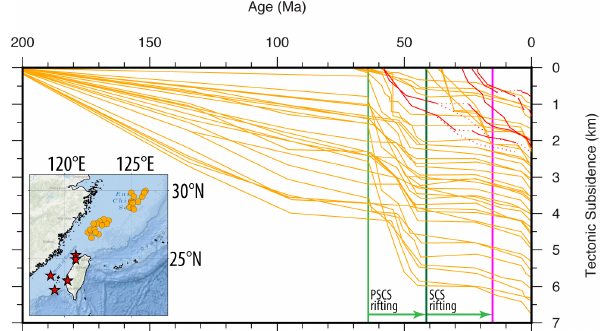
Fig. 15. Tectonic subsidence records from basins adjacent to Tai- wan and east China indicate an acceleration of tectonic subsidence from ∼ 65Ma that we interpret to be the opening of the proto-South China Sea (PSCS) as a back-arc basin, followed by another episode of subsidence in the mid-Eocene ( ∼ 42Ma) resulting from South China Sea (SCS) rifting. Figure modified from Lin et al. (2003) (red) and Yang et al. (2004)